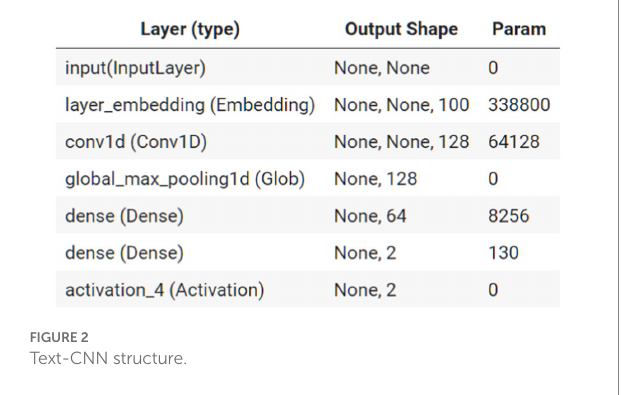
TABLE 3 The 20 most frequent words/phrases of each topic.